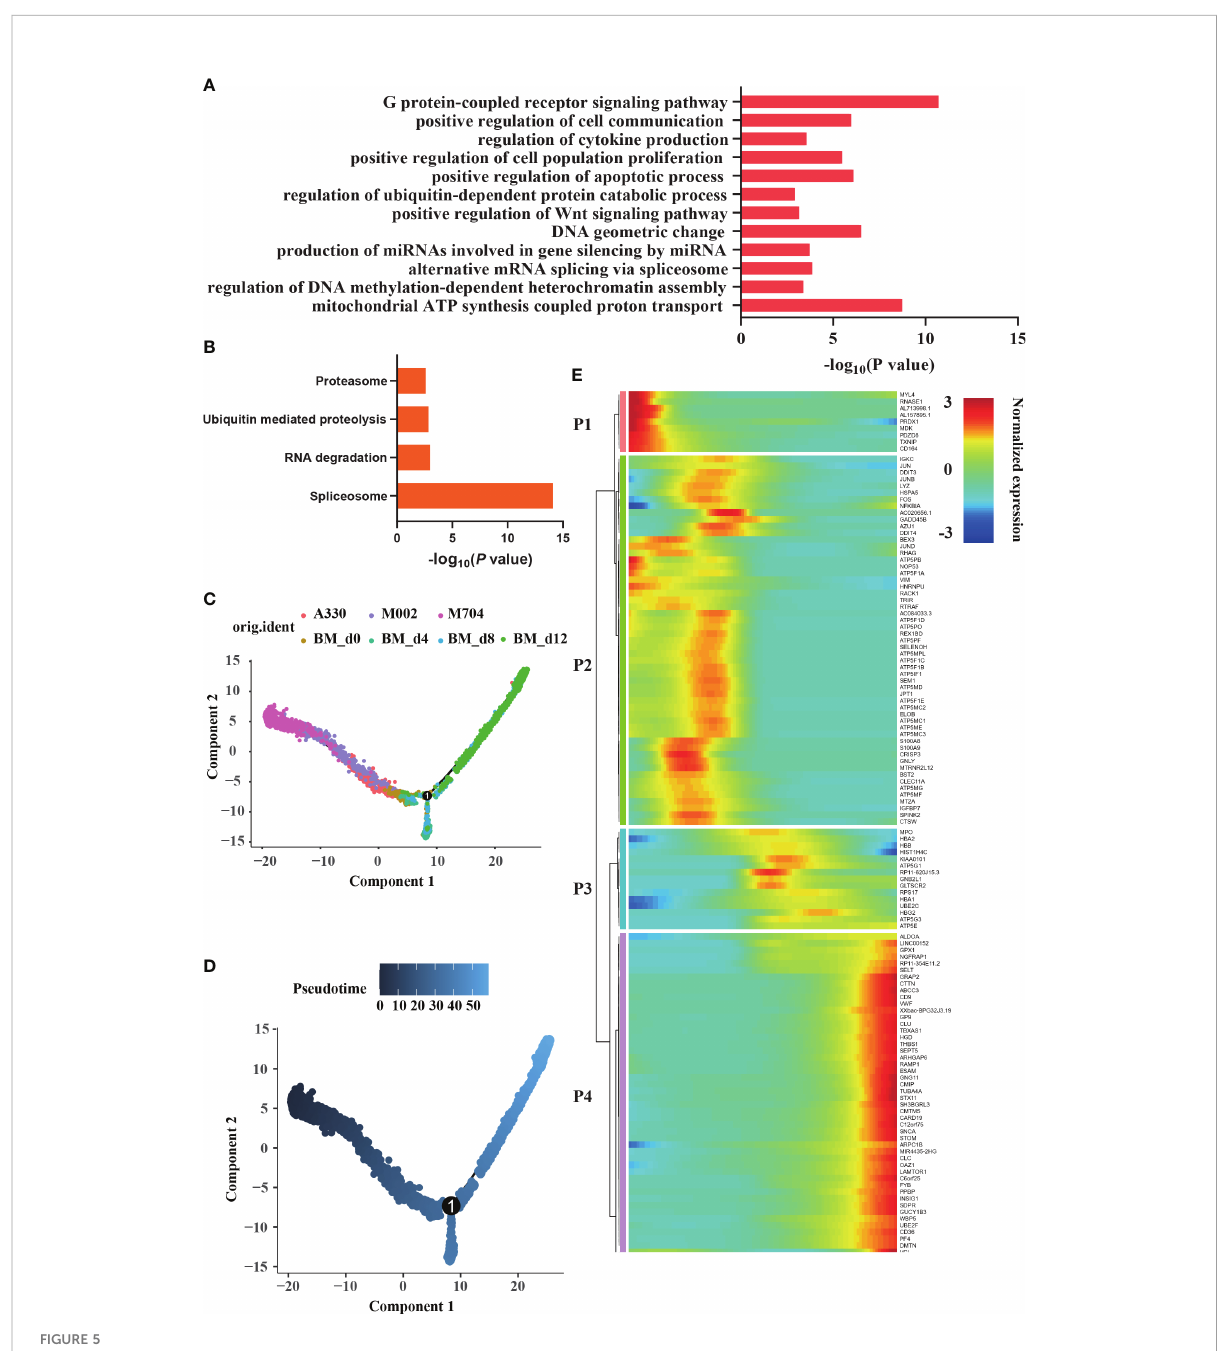
FIGURE 5 Enrichment and trajectory analyses of abnormal megakaryoblasts in AMKL and normal MK cells. (A, B) The enrichment of GO and KEGG of differentially expressed genes (DEGs) between megakaryoblasts in AMKL and normal MKs separately. (C, D) The trajectory analysis of megakaryoblasts in AMKL and normal MKs. The MKs (hiBM) were chosen from a human in vitro megakaryopoiesis model with time points of d0, d4, d8, and d12. (E) The heatmap showing the normalized expression of four gene sets naming P1, P2, P3, and P4. P1 stands for the DEGs highly expressed in tumors, while P4 stands for the ones highly expressed in normal mature